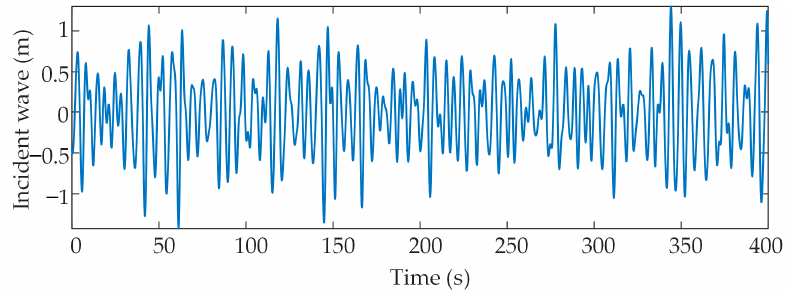
Figure 4. The incident wave with a spectral peak period of 6 s and an effective wave height of 1.2 m.